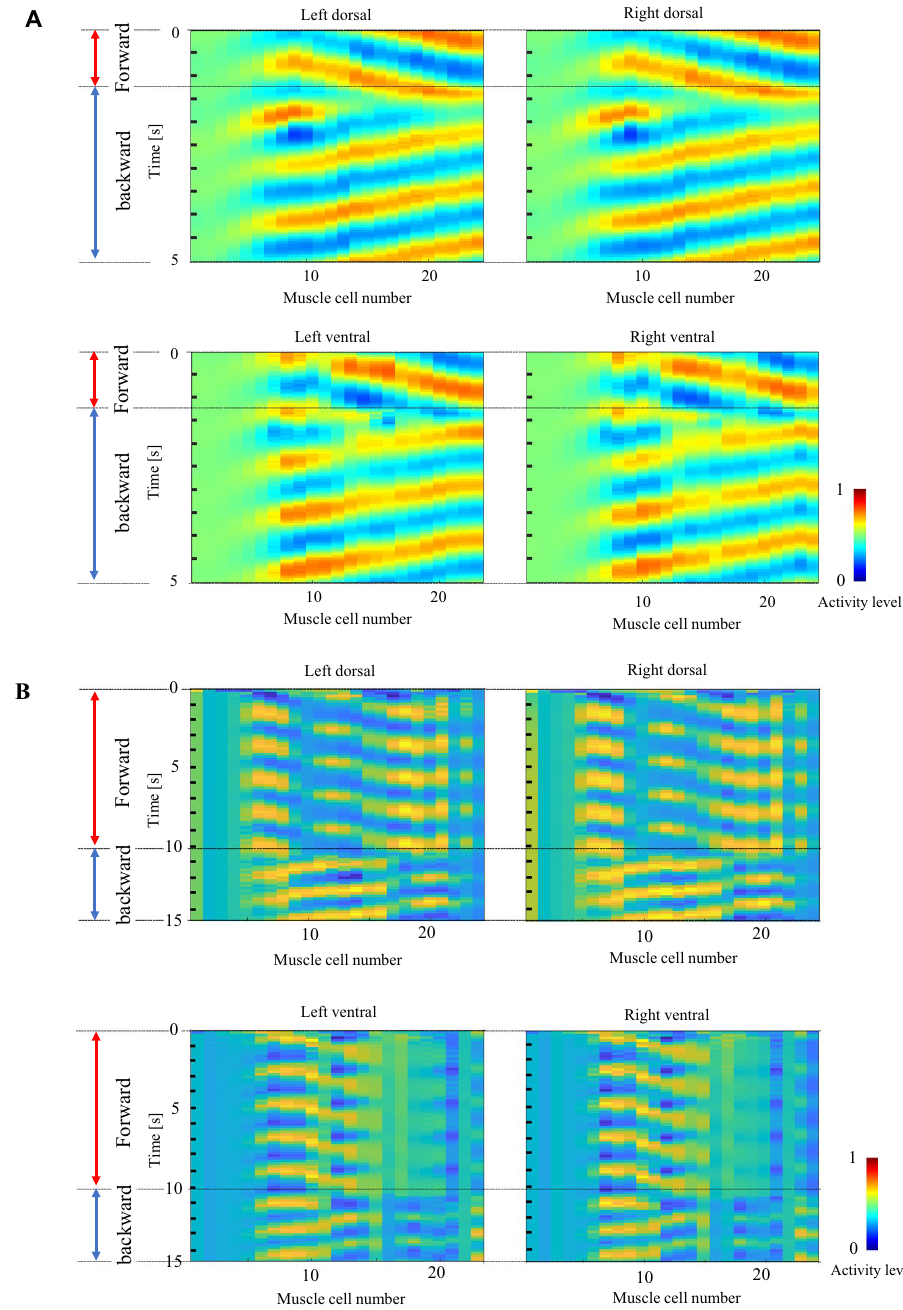
Figure 8. Muscle activities generated by the verification input. ( A ) and ( B ) show examples of the muscle activity generated by the trained models in a verification trial, which yielded the median value of the residual errors. The activity patterns corresponding to the forward and backward movements are successfully generated by switching the phase delay, as with the training